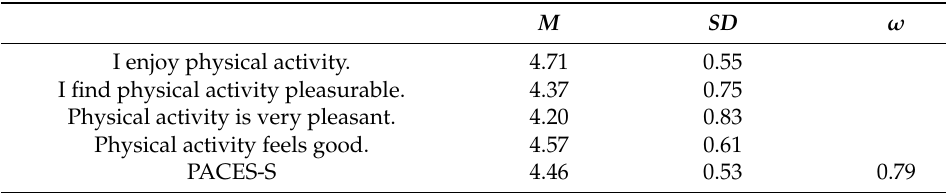
Table 1. Descriptive statistics of Study 1.